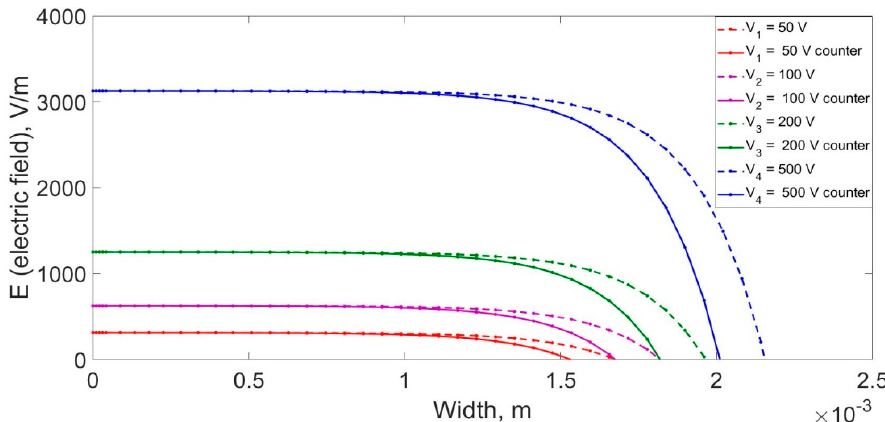
Figure 9. The impact of the counter flow of lithium-ions on the propagation of the electric field in the crystal during various voltage applications.